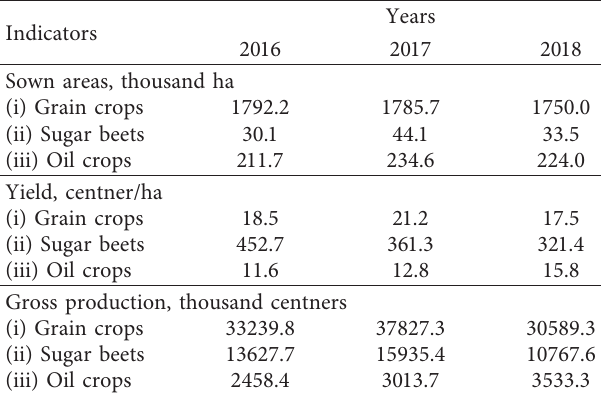
Table 1: Indicators of crop production in farms of all categories in the Republic of Bashkortostan for